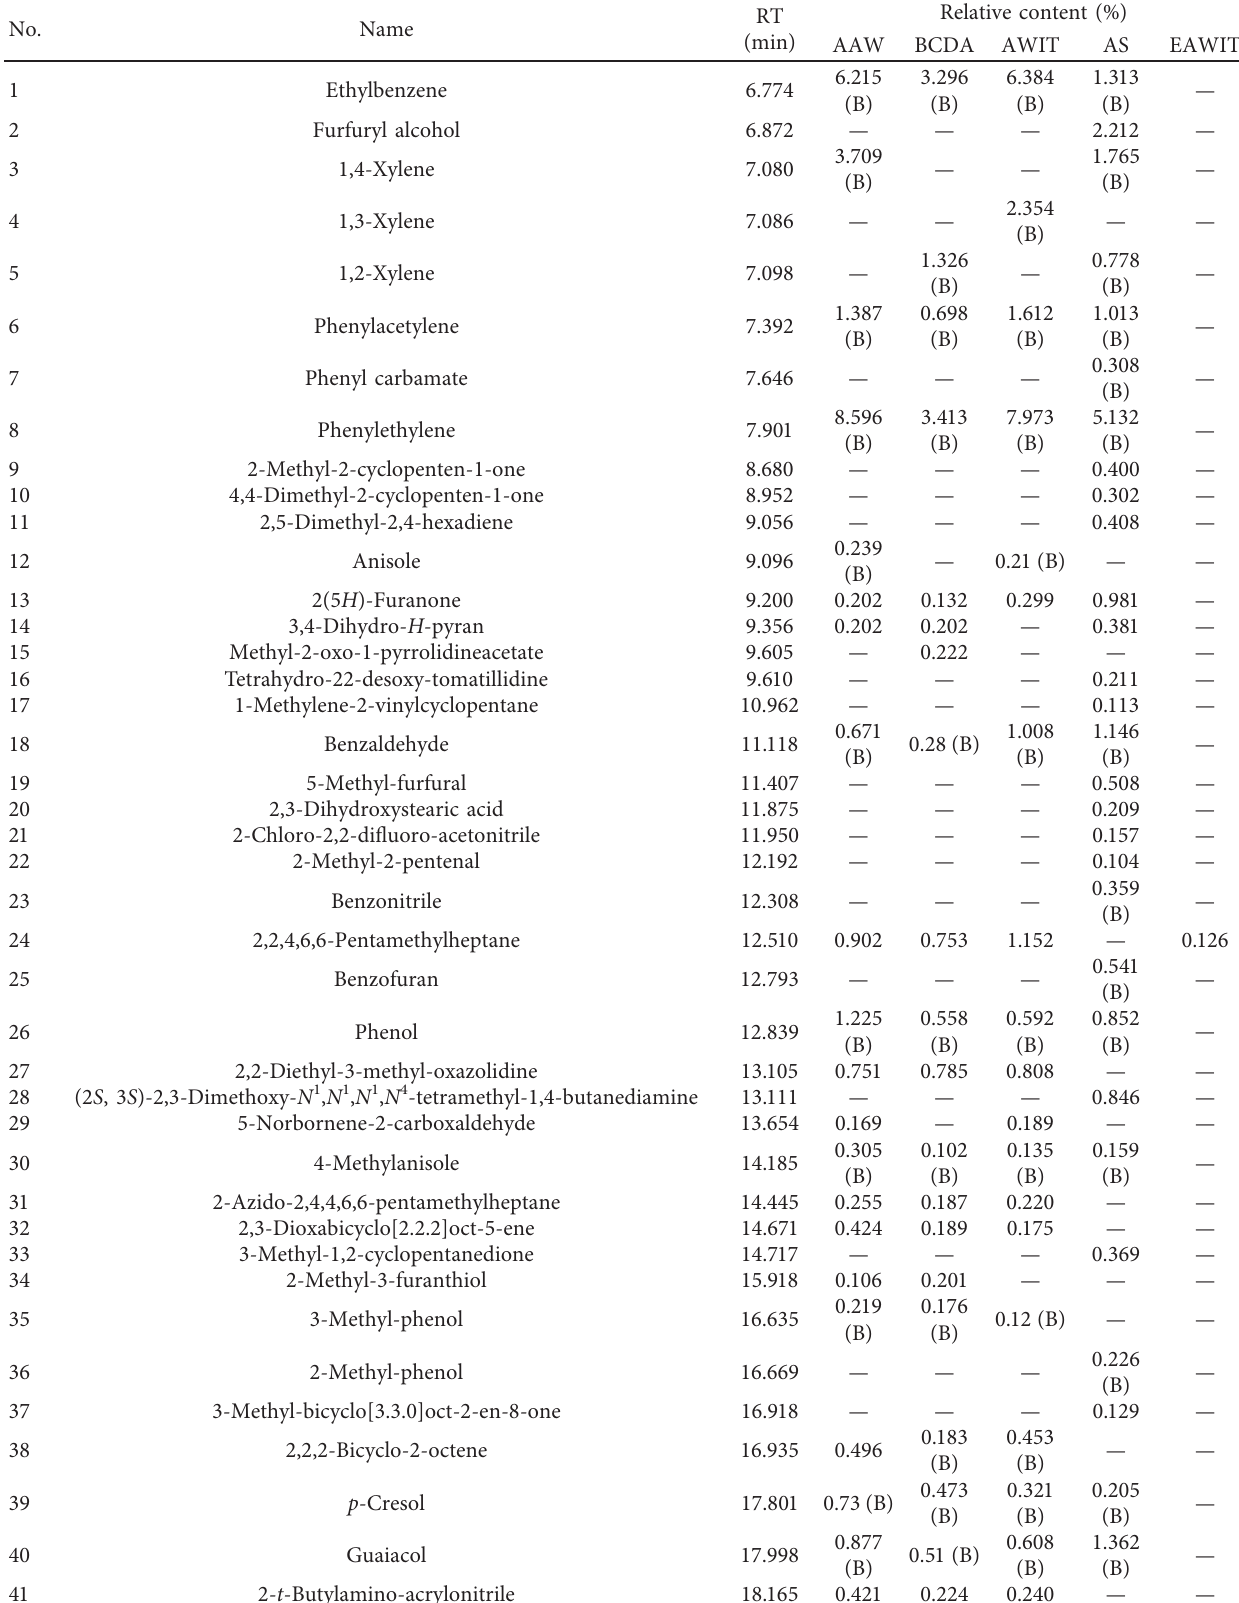
Table 1: Chemical constituents and relative amounts of AAW, BCDA, AWIT, AS, and EAWIT.